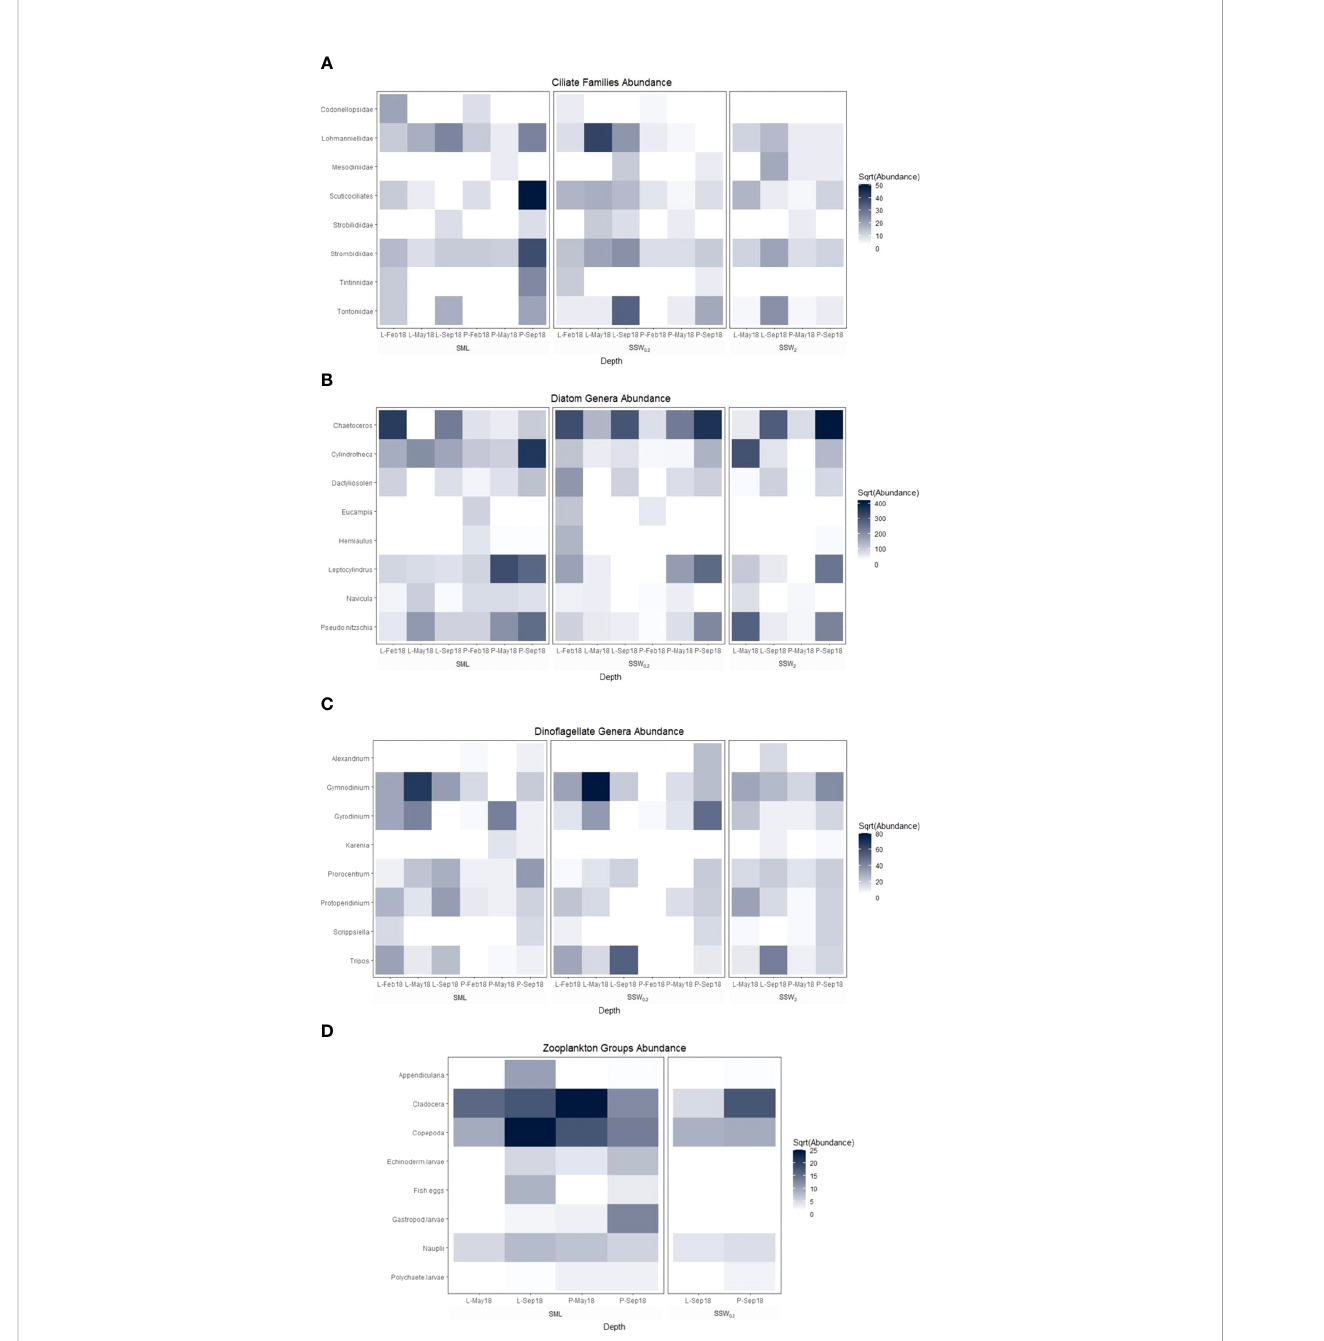
FIGURE 8 ATR-FTIR spectra of (A) all SML water samples collected from both sites and their comparison according to the sampling period, i.e., during (B) winter, (C) spring, and (D)